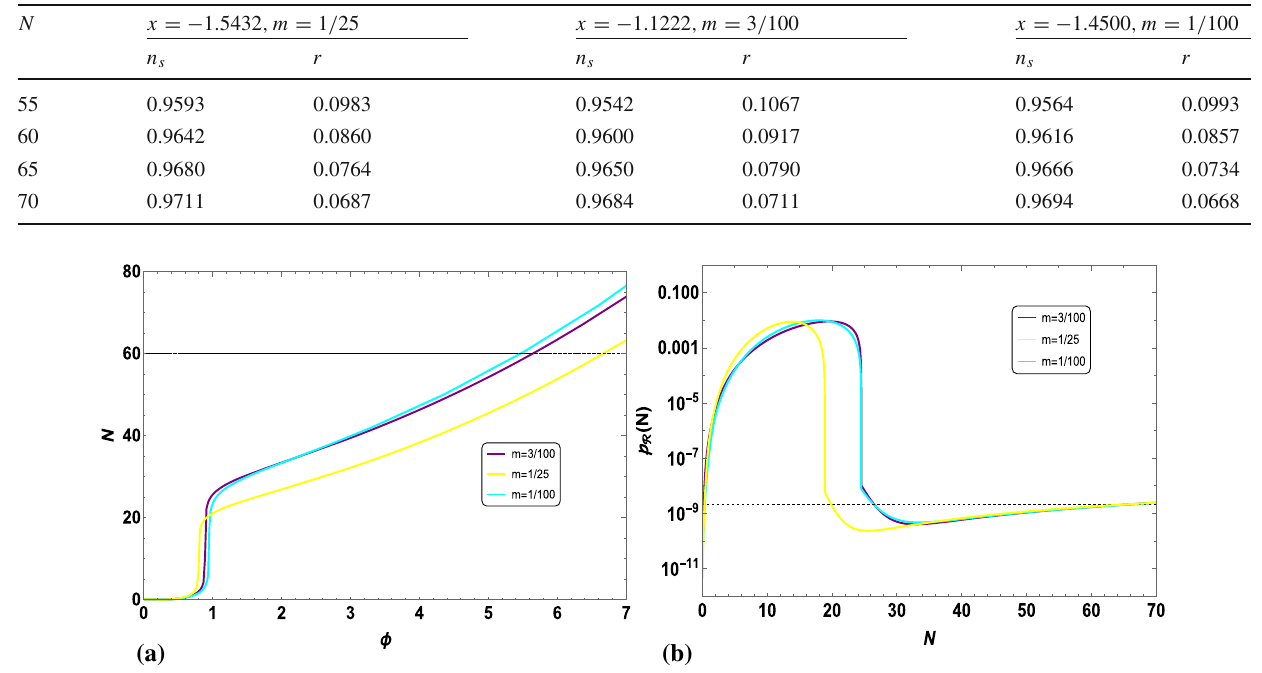
color corresponds to x = − 1 . 1222, cyan is for x = − 1 . 45 and yellow stands for x = − 1 . 5432. Peak in the P R can be seen clearly which is necessary for the production the PBHs. The black dotted line shows the value of P R ( = 2 . 1 × 10 − 9 ) at large scales and it is in good agree- ment with the Planck (cid:3) 18 [55]. Enhancement in the power spectrum is calculated numerically using Eq. (5)